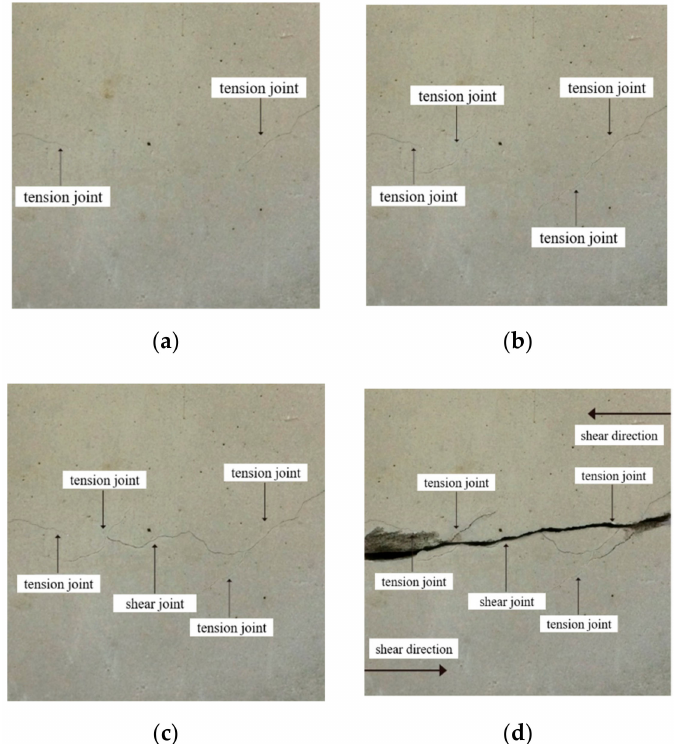
Figure 16. Shear failure of collinear cracks specimens. ( a ) Initial failure of the specimen, ( b ) Crack propagation failure, ( c ) Crack penetration failure, ( d ) Final failure of the